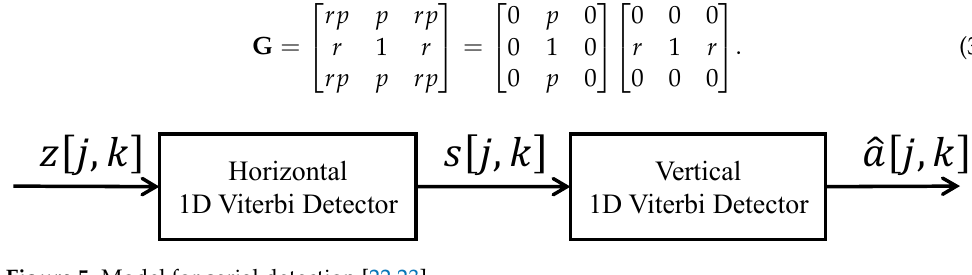
Figure 4. Trellis for the detection of the 3-way GPR target.